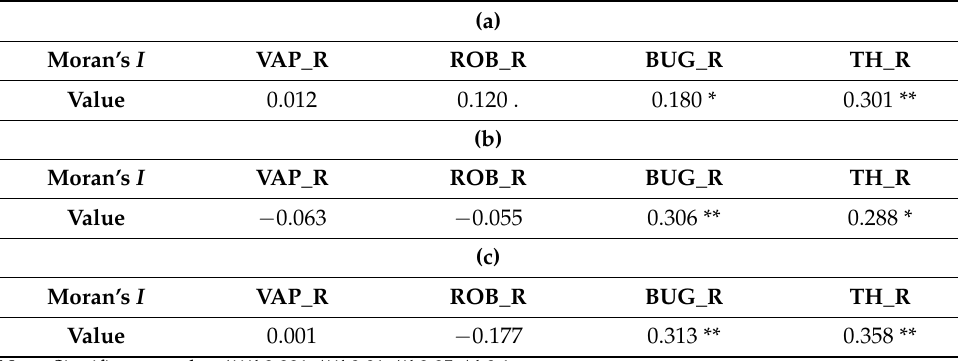
Table 3. Univariate Moran’s I test of crime rate for three months. ( a ) March 2020 ( N = 32); ( b )